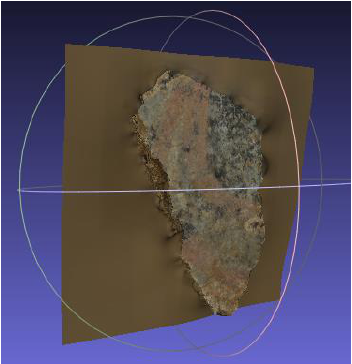
Figure 8: 3D triangular mesh with unnecessary information